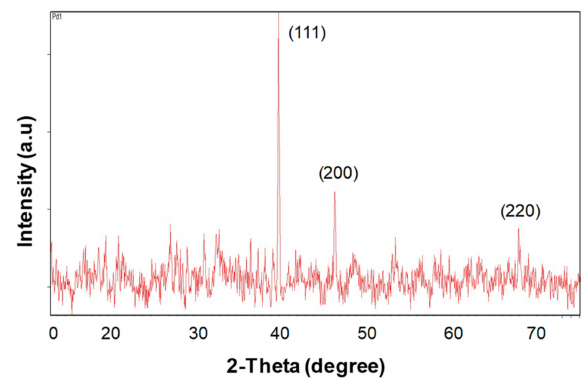
Figure 3. X-ray diffraction (XRD) pattern of GTL σ -A193Cp-PdNPs bionanohybrid. The content of palladium in the solid was 40 wt.% measured by inductively coupled plasma atomic emission spectrometry (ICP-OES). More than 99% of the enzyme offered was remaining in the final bionanohybrid confirmed by Bradford assay [19]. TEM analysis showed that ultra-small spherical palladium nanoparticles (PdNPs) were synthesized into the protein network of GTL σ -A193Cp with a size distribution of 2 to 4 nm, but mainly with a size around 3 nm (Figure 4).